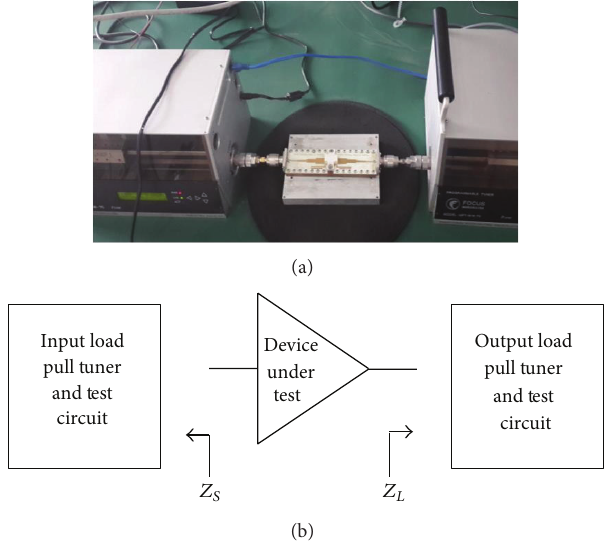
Table 1: RF performance of the W-sinker RF LDMOS product.